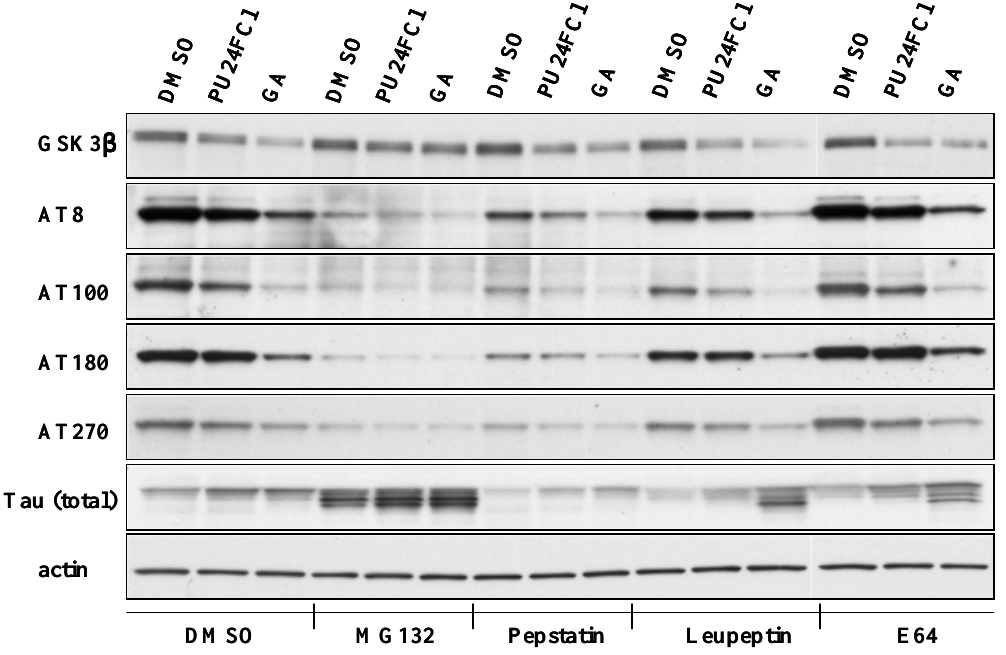
Figure 3. Degradation of GSK3 b  by Hsp90 inhibitors is mediated by the proteasome. Only proteasome inhibitors (i.e. MG132) were able to prevent the degradation of GSK3 b  over a 20 h treatment with the Hsp90 inhibitors PU24FCl and GA. Primary neurons were treated with DMSO, 10 µ M PU24FCl or 400nM GA in the presence of the following inhibitors: 10 m M MG132, 1 m M pepstatin, 75 m M leupeptin, 10 m M E64 or 20 m M ZVAD for 20h. Cells were collected, lysed and the resulting lysates analyzed by immunoblot. Proteins were analyzed by Western blot. The phosporylation level of tau protein was analyzed by Western blotting using phospho-specific antibodies [AT8 (1:250), AT100 (1:250), AT180(1:250), AT270 (1:250)] anti total tau antibody (1:500). Actin were used as protein quantification